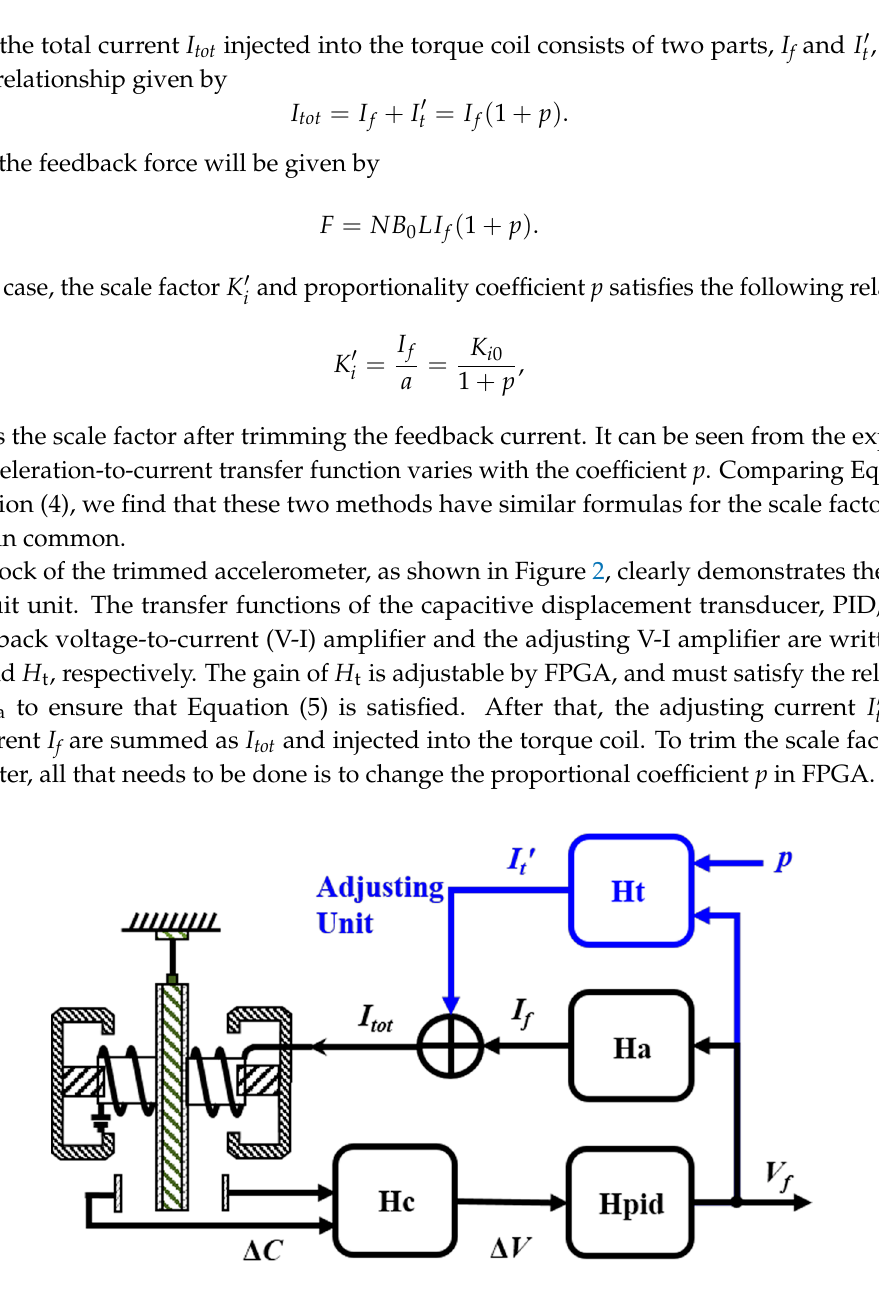
Figure 2. The block of the transfer function for the scale factor trimming. The value of the coefficient p can be provided numerically by FPGA according to the actual needs.